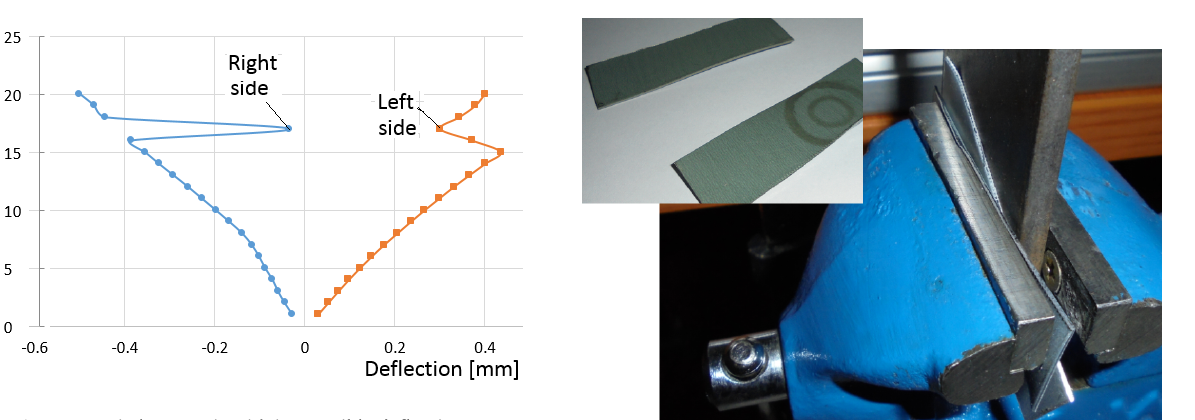
Figure 6: Increase in hysteresis with irreversible deflection.